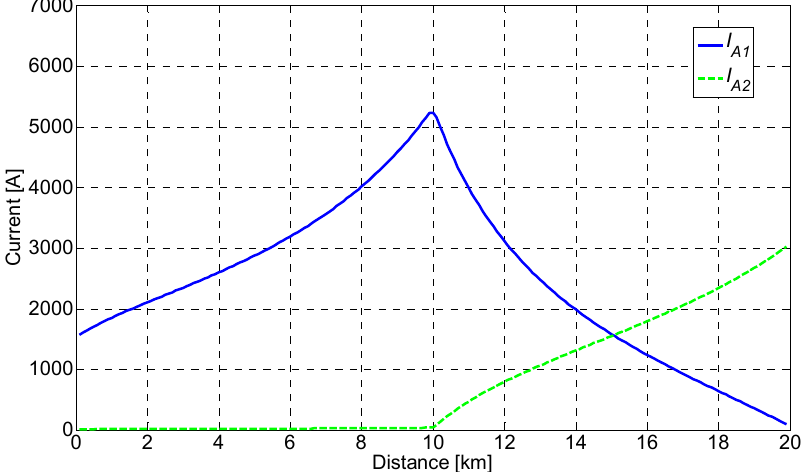
Figure 8. Currents in autotransformers as a function of the distance from the traction substation when a ground fault occurs between the catenary and rail along different zones in a section with two subsections.